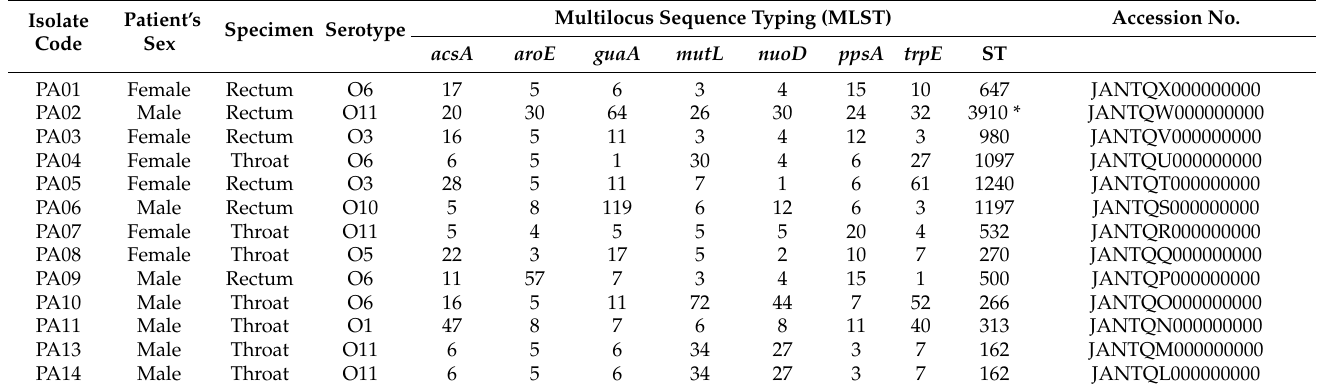
Table 2. Sequence types (STs) and serotypes of the colonizing isolates of P. aeruginosa